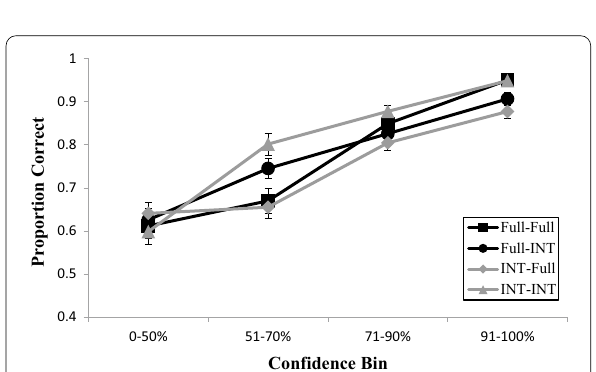
Fig. 14 CAC curves across the four combinations of test face type (Full Face versus Internal Features only) and procedure (lineup versus showup), with standard error